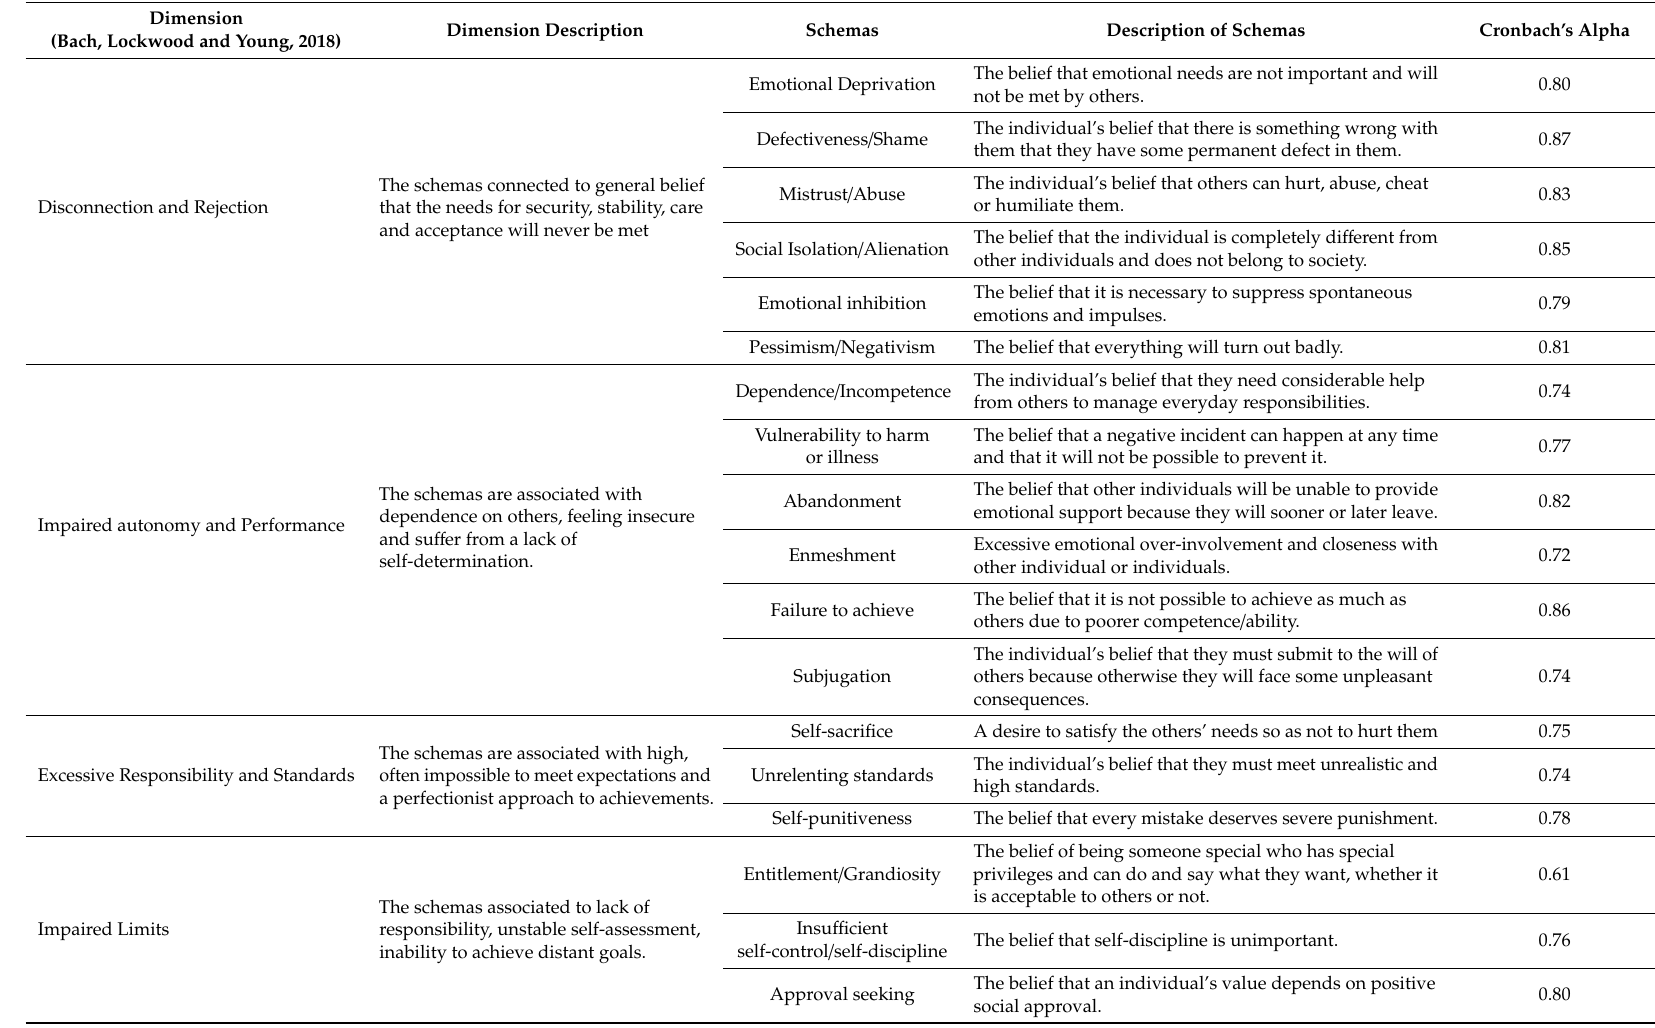
Table 1. Description of Early Maladaptive